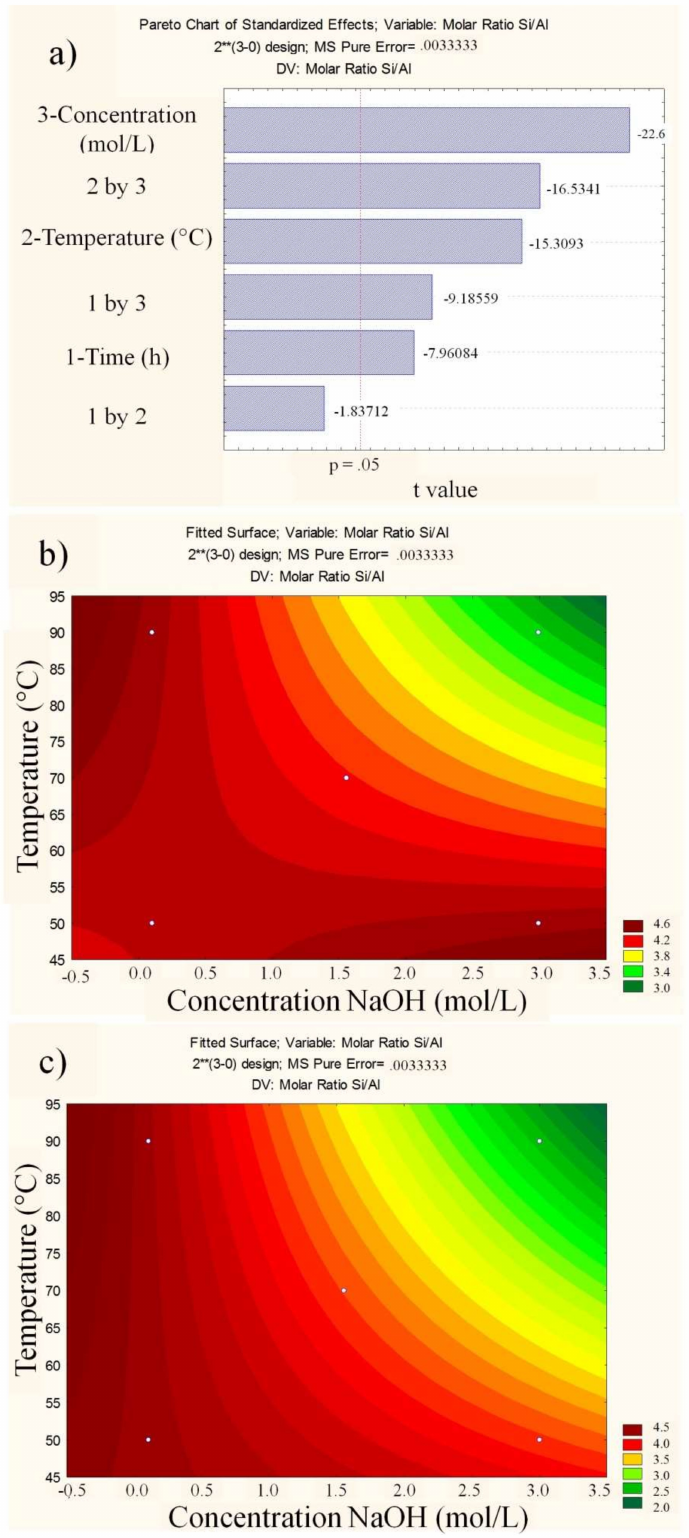
Figure 4. Statistical analysis. ( a ) Effect of the parameters on the response Si/Al molar ratio. Response surface for ( b ) time = 0.5 h, ( c ) time = 4